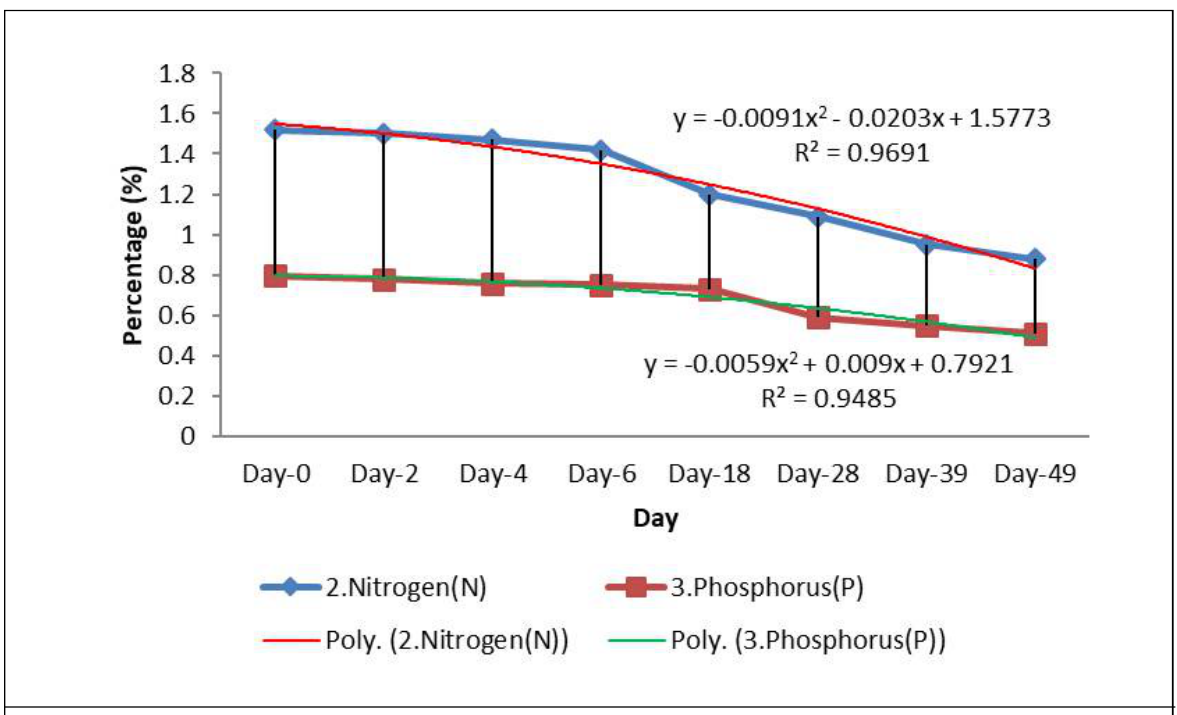
Figure 5: Nitrogen and phosphorous variation trend during WBM ( A. bisporus ) composting and